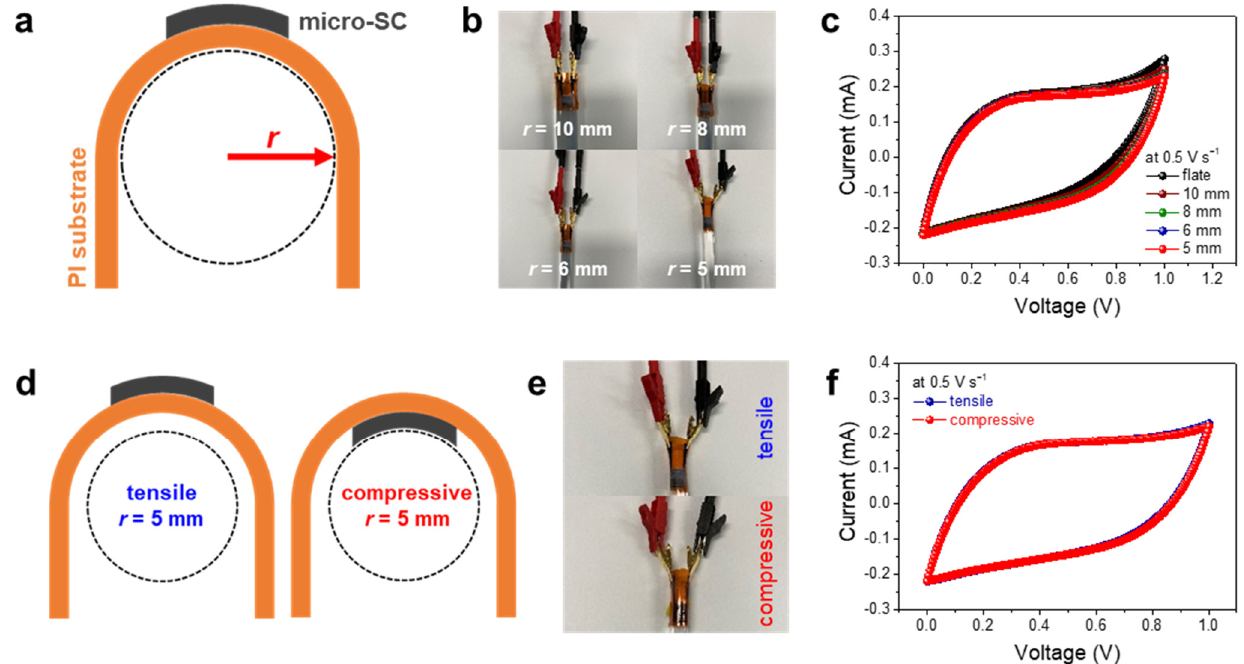
Figure 4. ( a ) Schematic illustration of bending states for HQ-MSCs. ( b ) Photographs and ( c ) CV curves of various bending states with bending radii of 5, 6, 8, and 10 mm for HQ-MSCs. ( d ) Schematic illustration and ( e ) photographs of HQ-MSCs under tensile and compressive strains. ( f ) CV curves of HQ-MSCs under tensile and compressive strains.